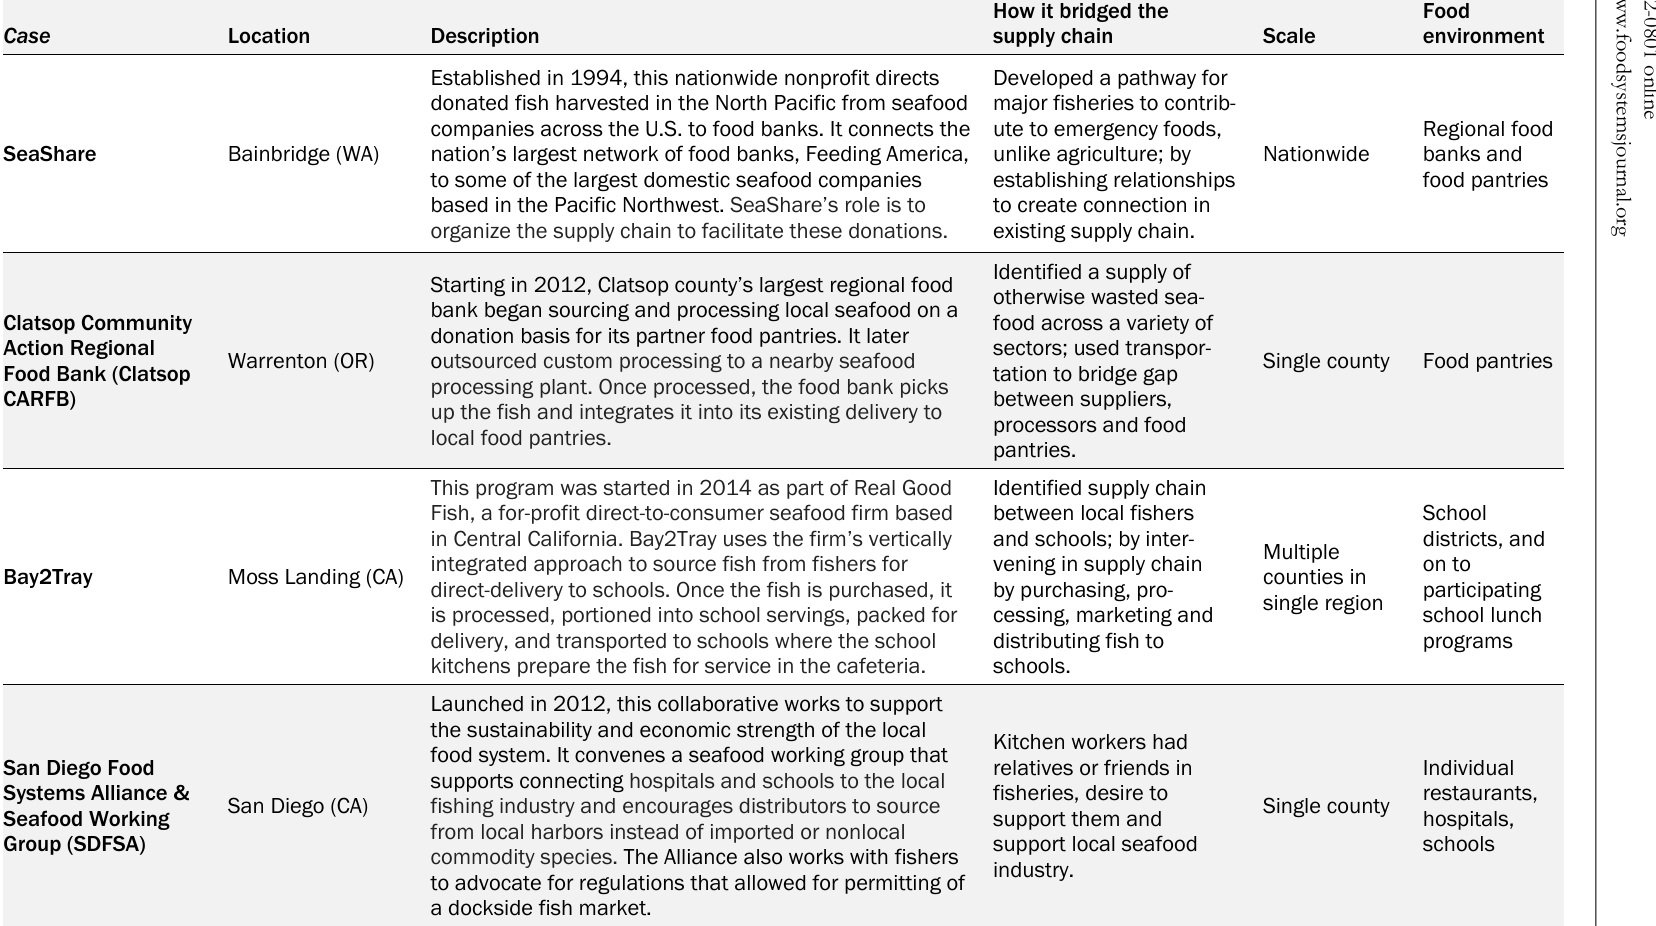
Table 2. Characteristics of U.S. West Coast Positive Deviant Cases Connecting Underutilized Fish to Food Insecure and Nutritionally Vulnerable Populations